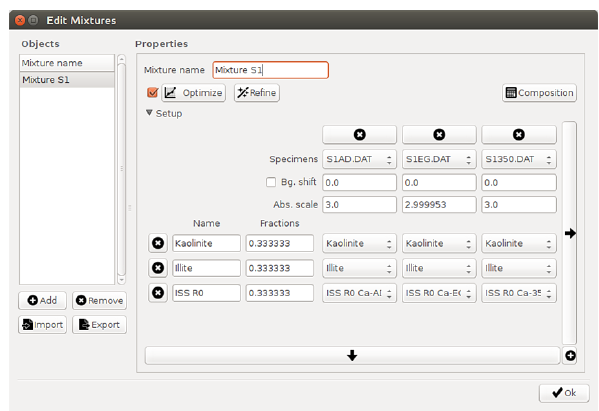
Figure 2. Screenshot showing the “Edit mixtures” dialog where a user can link different phases (kaolinite, illite, ISS R0 Ca-AD, etc.) with the corresponding specimens (S1AD.dat, S1EG.dat,